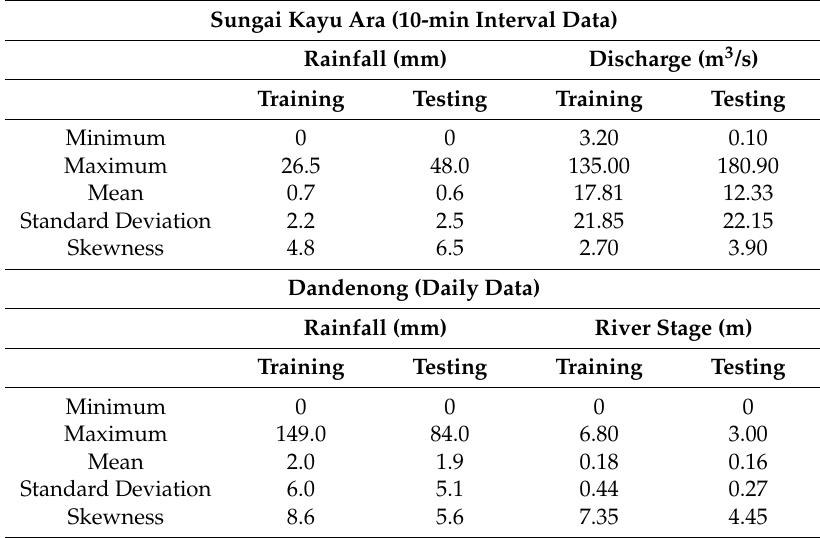
Table 1. Statistical analysis of the data used for Sungai Kayu Ara and Dandenong